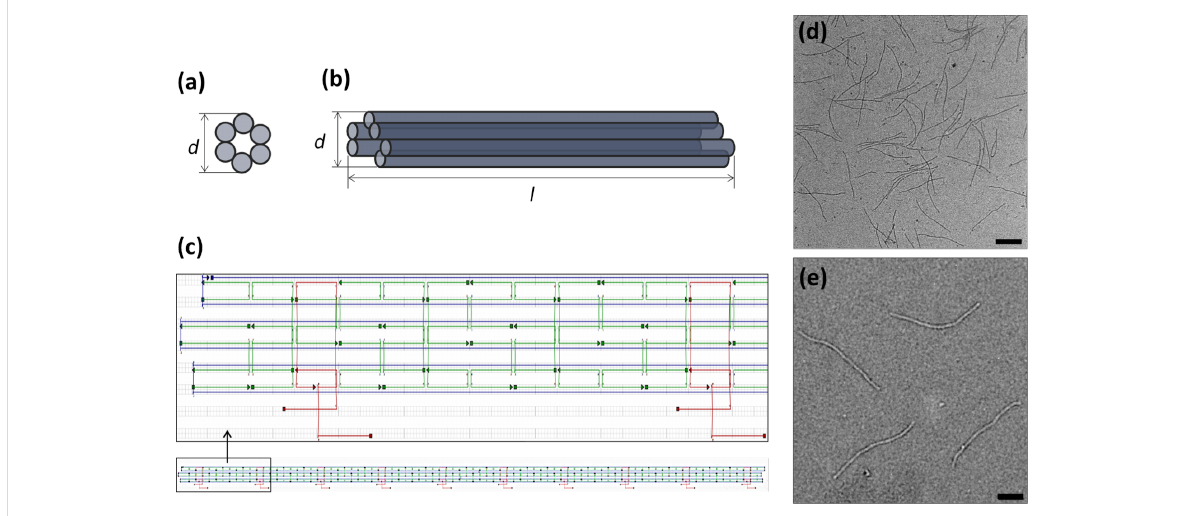
Figure 1: Six-helix bundle. The (a) front and (b) side view of the six-helix bundle are schematically depicted (diameter: d = 6 nm, length: l = 414 nm). (c) caDNAno design representation with the template strand in blue, and main and capture staples in green and red, respectively. The capturing strands are 126 bases apart from each other on both helices. (d,e) TEM images of the resulting tubular DNA structures. The scale bar is (d) 200 nm and (e) 100